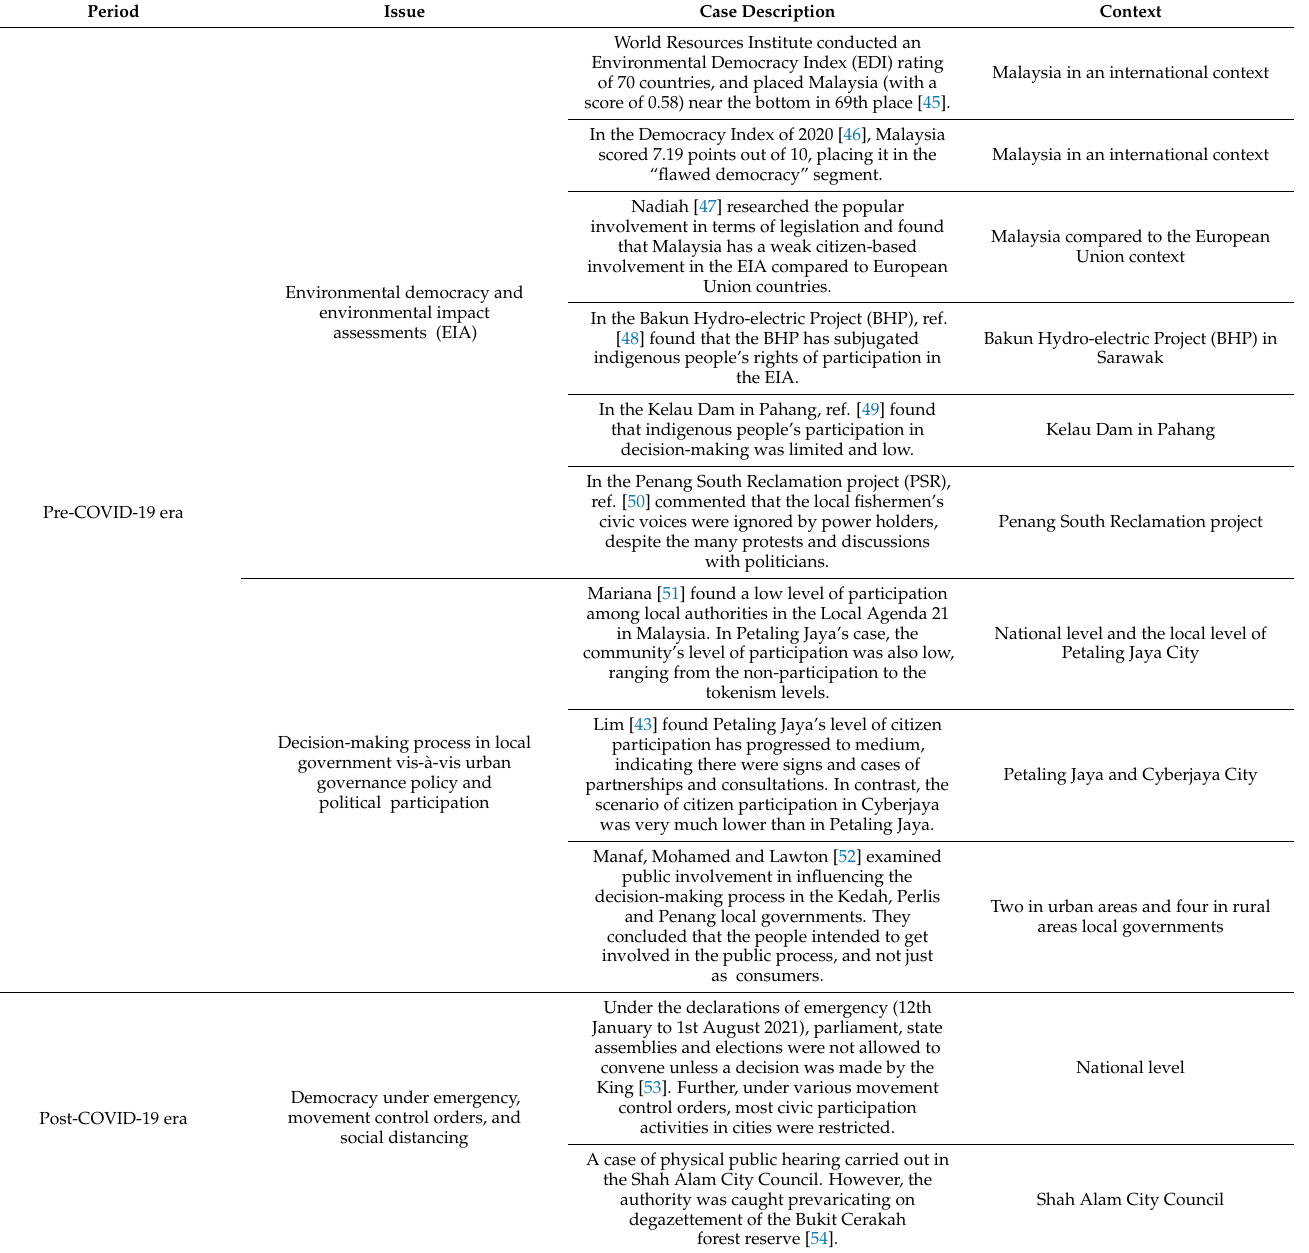
Table 1. The summary of selected Malaysian